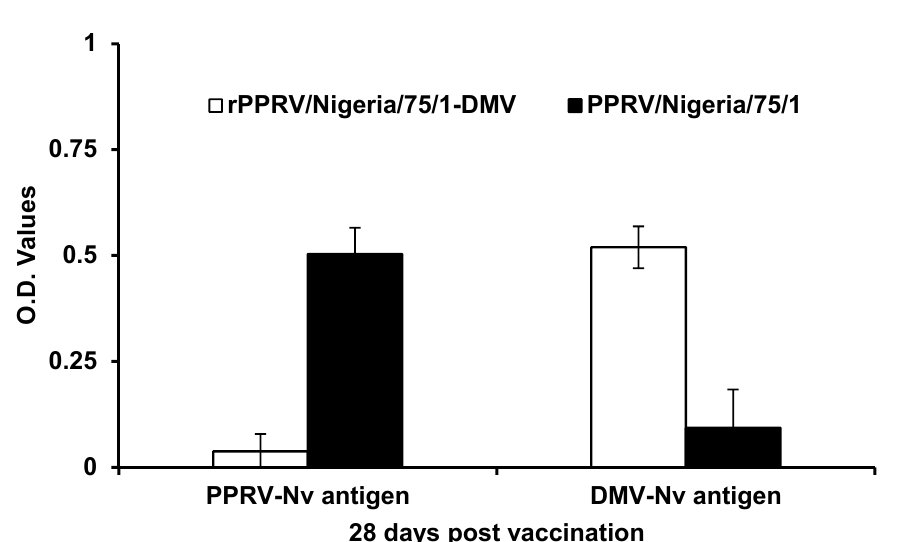
Figure 9. Mean optical density against the native PPRV N-protein and DMV N-protein in DIVA ELISA. The assay was carried out using 28 days post-vaccination serum samples.